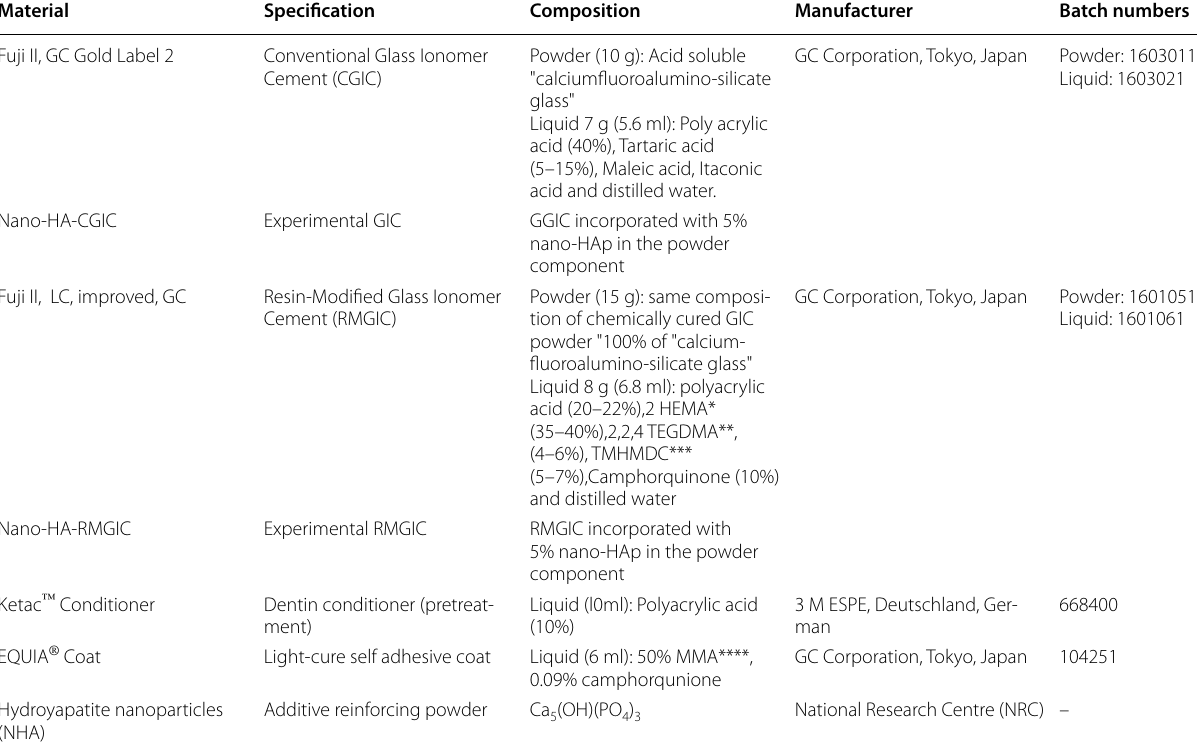
*HEMA: hydroxyethyl-methacrylate; **TEGDMA: Triethlene-glycol dimethacrylate; ***TMHMDC: Trimethyl-hexamethylenedicarbonate; ****MMA: Methyl-methacrylate